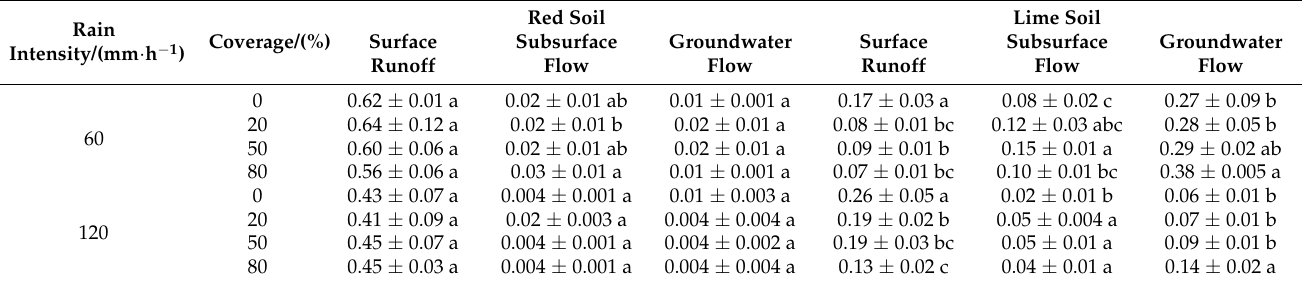
Table 2. Runoff coefficient of red soil and lime soil with different straw